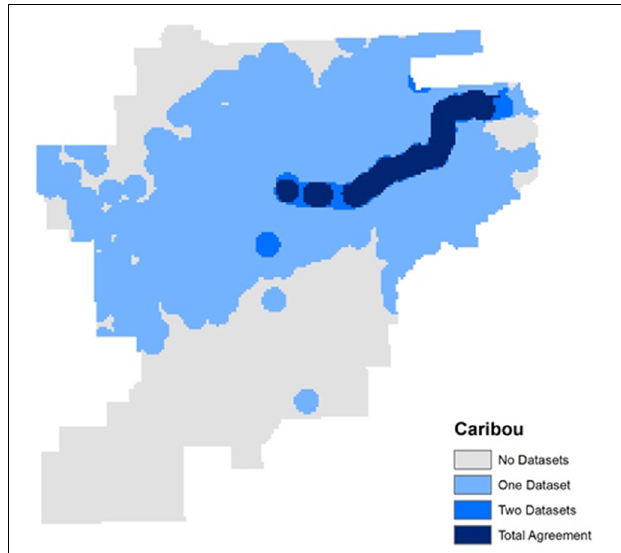
FIGURE 8 | Aptness Component results, areas of dark blue show agreement amongst the three datasets. but does not need to manage another citizen science program.